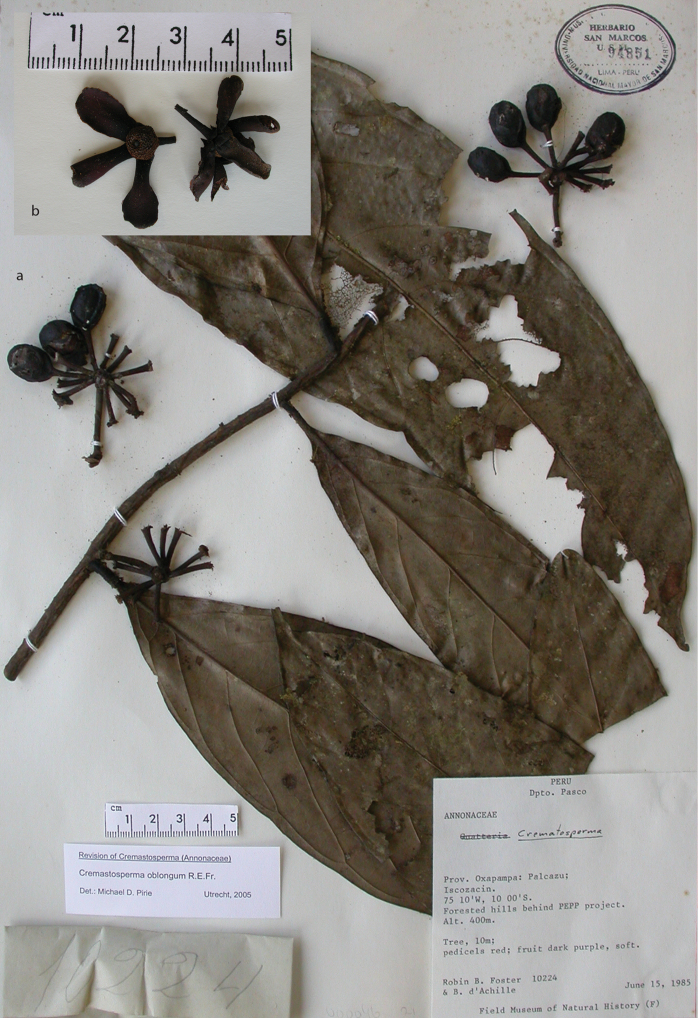
Cremastospermaoblongum R.E.Fr. a fruiting specimen b flower (aFoster & d’Achille 10224; bMaas et al. 4592).